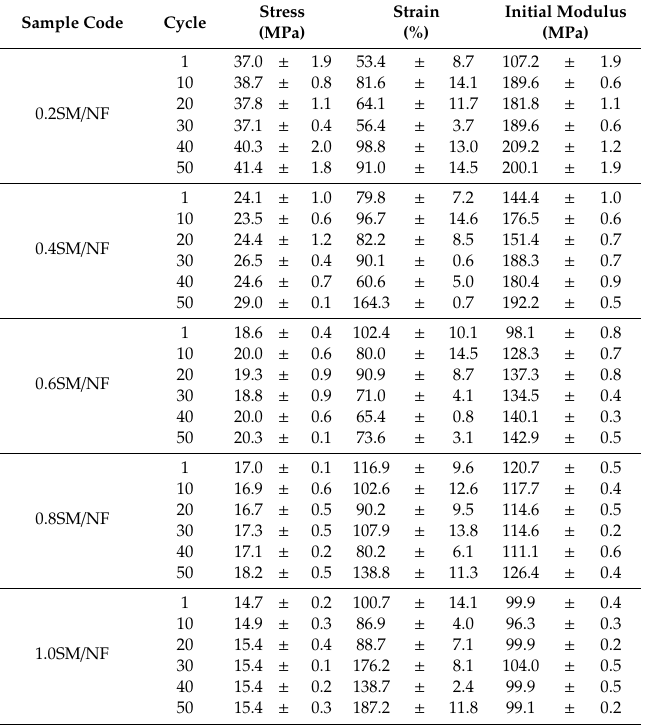
Table 4. Tensile property of a 3D-printed sinusoidal sample / nylon composite with various thicknesses and various